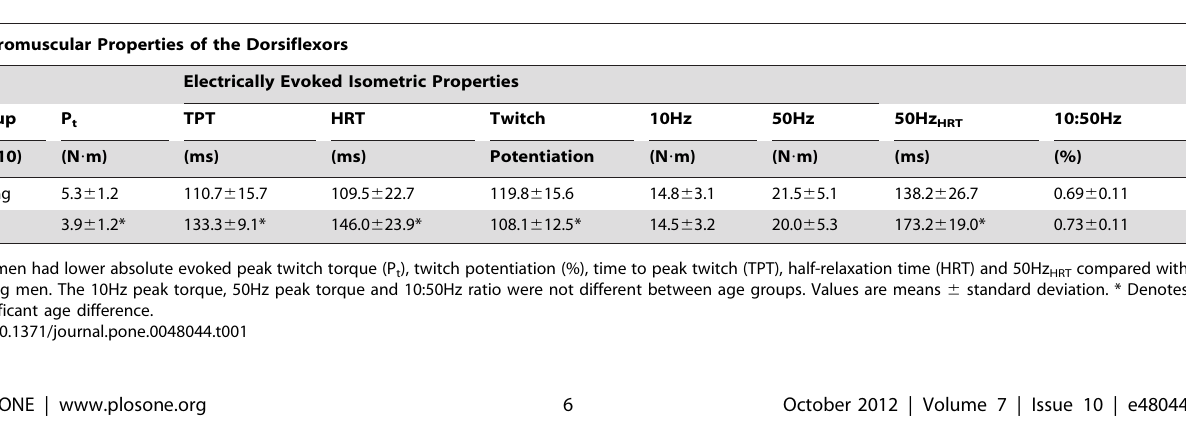
Figure 3. Relationship between the ratio of eccentric strength to concentric strength (Ecc:Con) and residual force enhancement (RFE) for old (closed circle) and young (open circle) (A.). Relationship between the ratio of eccentric strength to concentric strength (Ecc:Con) and passive force enhancement (PFE) for old (closed circle) and young (open circle) (B.). Relationship between the passive force enhancement (PFE) residual force enhancement (RFE) for old (closed circle) and young (open circle) (C.).